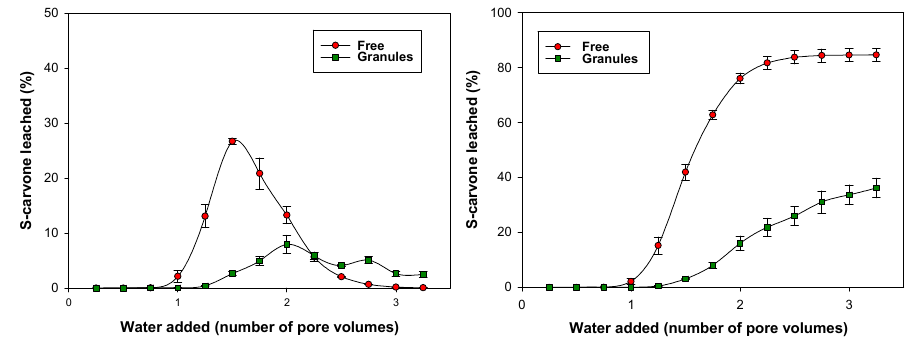
Figure 4. Breakthrough curves (BTCs) for S-carvone applied to soil columns as free compound or supported on granules: Relative curves ( left ) and cumulative curves ( right ).